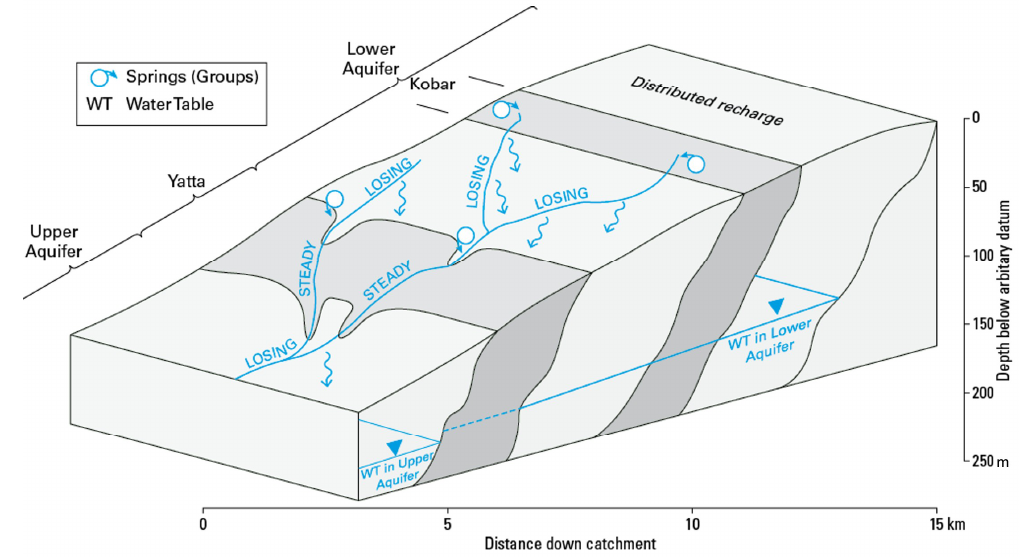
Figure 3. Conceptual model of recharge processes in the Wadi Natuf